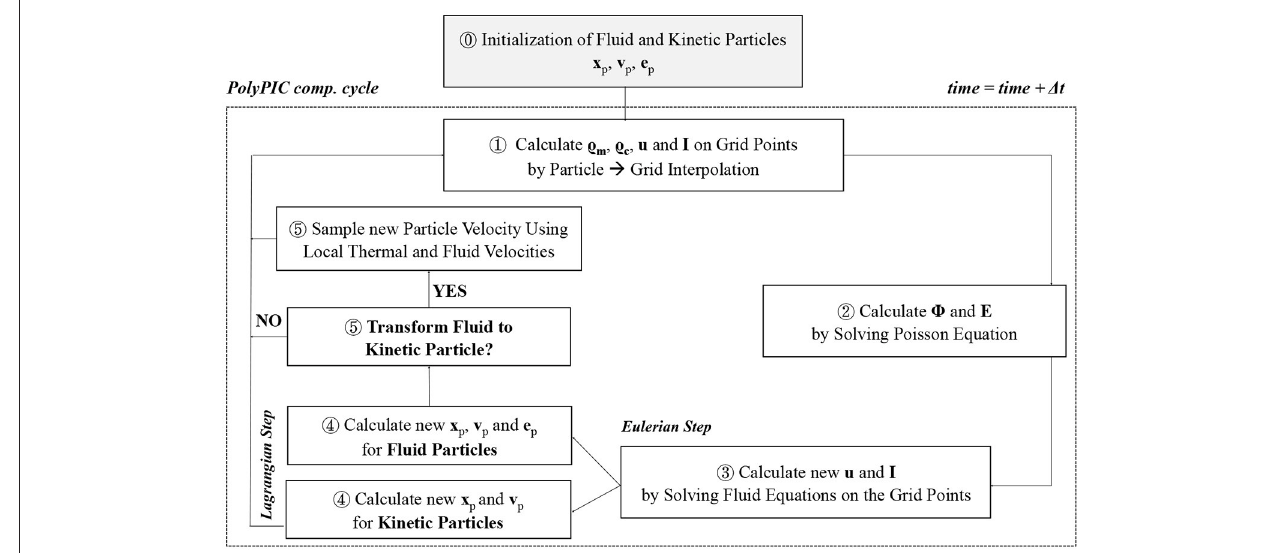
FIGURE 2 | The computational cycle of the PolyPIC method.